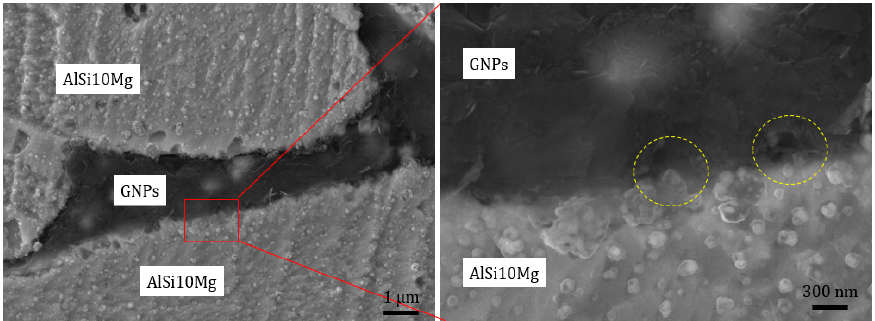
Figure 5. SEM micrographs of a representative interface between the AlSi10Mg/GNPs after hot consolidation.